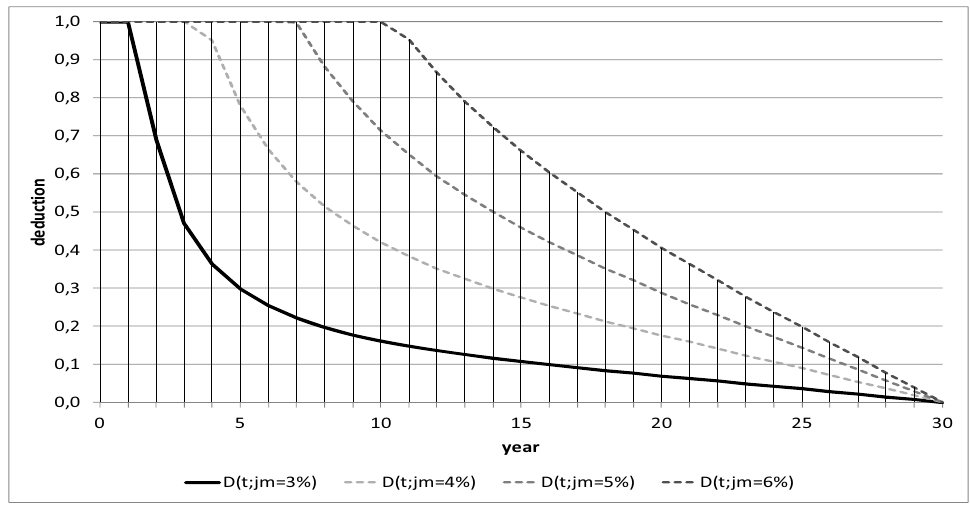
Fig. 3C. Average values of the distributions of